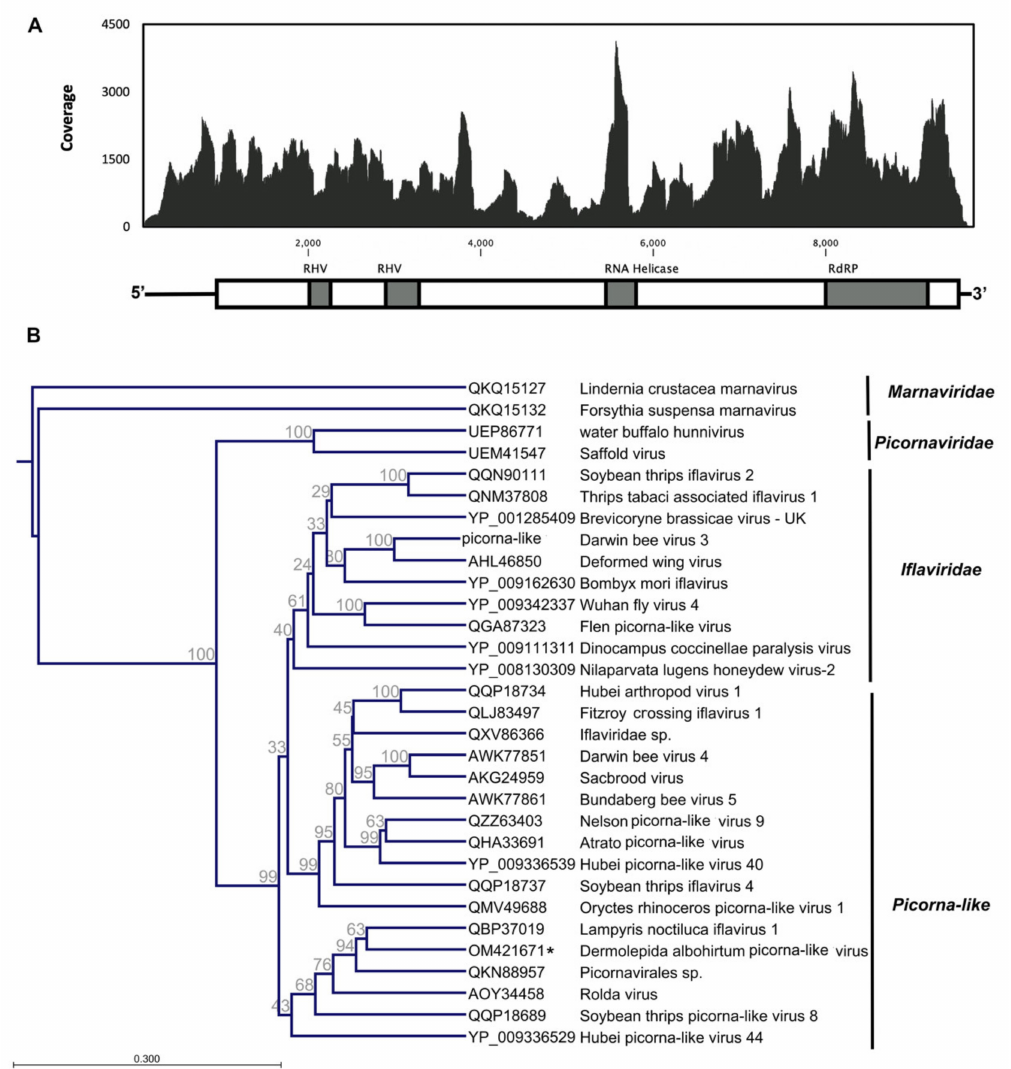
Figure 2. Schematic diagram of the genome organization and coverage of Dermolepida albohirtum picorna-like virus ( A ). The maximum likelihood phylogeny of the novel picorna-like virus (DaPV1) and previously reported viruses in the Picornavirales based on deduced amino acid sequence of conserved RdRP domain. DaPV1 is clustered with other members of unclassified Picornavirales and some members of family Iflaviridae . We used two members of family Marnaviridae as outgroups in this analysis. The identified virus in this study is shown with an asterisk ( B